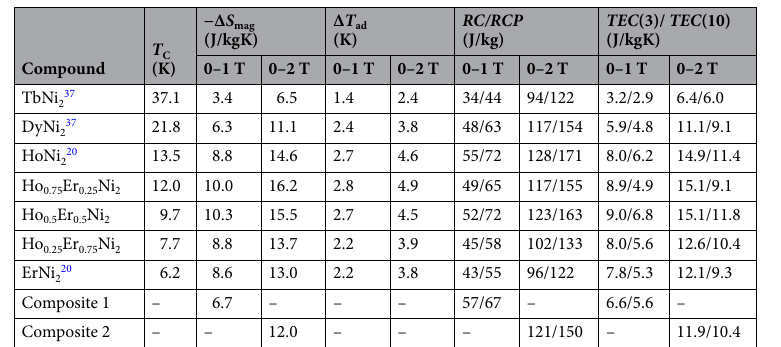
Table 2. Magnetocaloric properties for the selected binary RNi 2 compounds and for the investigated Ho 1-x Er x Ni 2 solid solutions estimated from heat capacity measurements for magnetic field changes of 1 and 2 T. T C is the magnetic phase transition temperature; -Δ S mag is the maximum magnetic entropy change; Δ T ad is the maximum adiabatic temperature change; RC is the refrigerant capacity; RCP is the relative cooling power; and TEC is the temperature averaged entropy change. The values of the characteristic temperatures were calculated to an accuracy of ± 0.1 K. The magnetic entropy was calculated to an accuracy of ± 0.1 J/kgK.